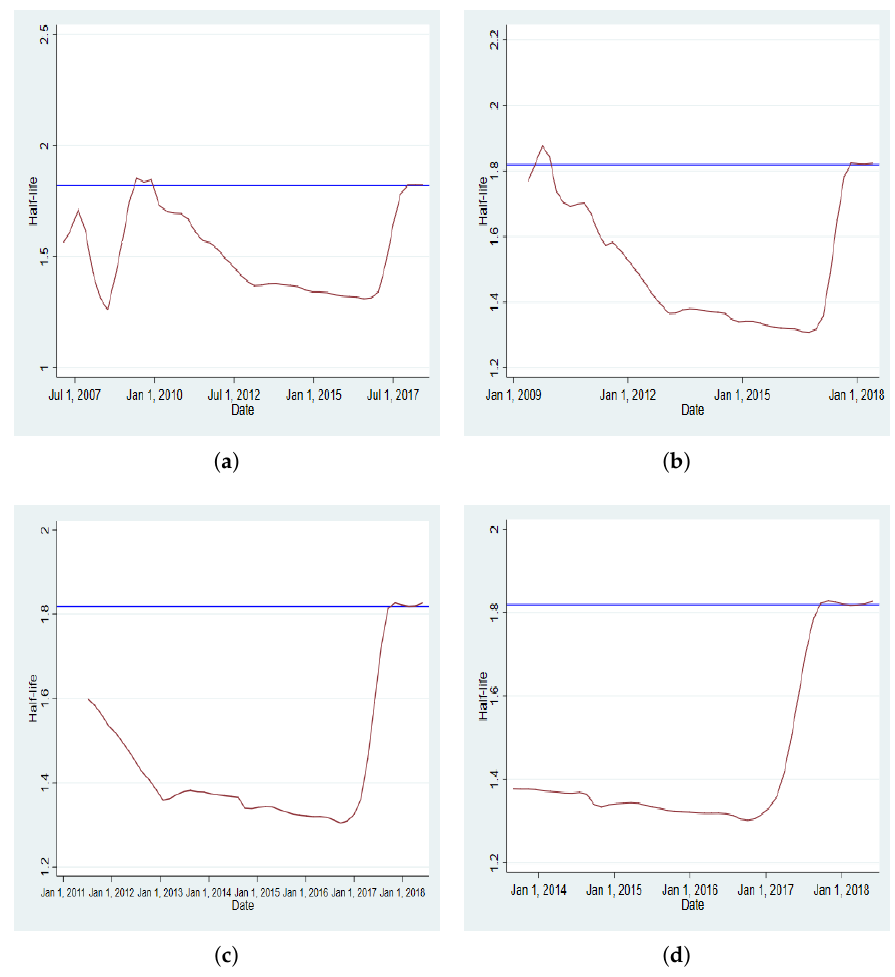
Figure A6. Dynamics of half-time for the BRVM10 index using recursive rolling regression. These graphs plot the half-time estimated using rolling regression. The date is the end date for a selected window. In ( a ), the half-time is 1.2 days using recursive rolling regression with a window whose end date is 1 July 2007. ( a ) Dynamics of half-time for the BRVM10 index using recursive rolling regression with a 2-year window; ( b ) Dynamics of half-time for the BRVM10 index using recursive rolling regression with a 4-year window; ( c ) Dynamics of half-time for the BRVM10 index using recursive rolling regression with a 6-year window; ( d ) Dynamics of half-time for the BRVM10 index using recursive rolling regression with an 8-year